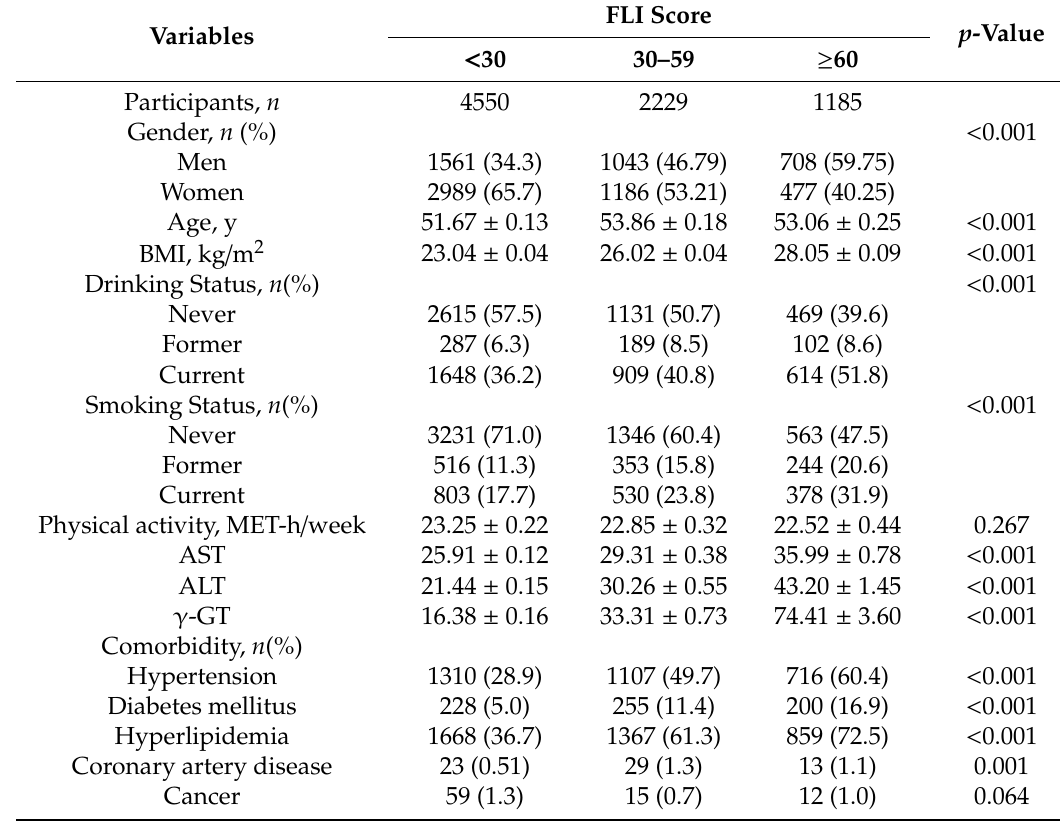
Table 1. Baseline characteristics of the study participants according to fatty liver index (FLI)